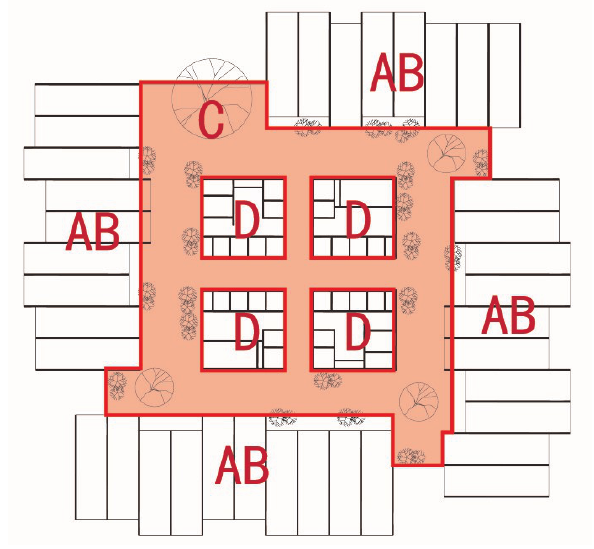
Fig. 2 Analysis of plane spatial structure in Shenzhen Vertical